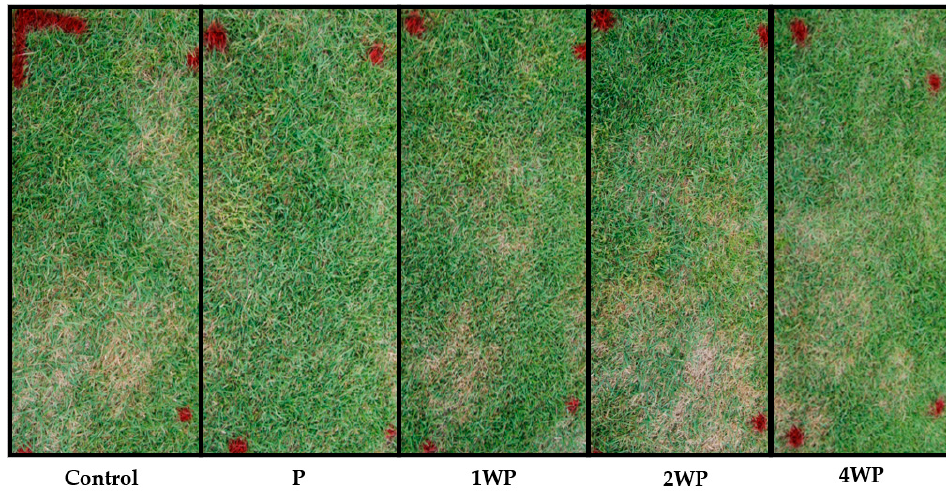
standard error. Control efficiency (%) = (1 − disease area of treated sample/mean disease area of control sample) × 100. Table 2. Diseased area and control efficiency of large patch disease in zoysiagrass after the applica- tion of various treatments containing Bacillus subtilis SA-15 (WP) and pencycuron (P).